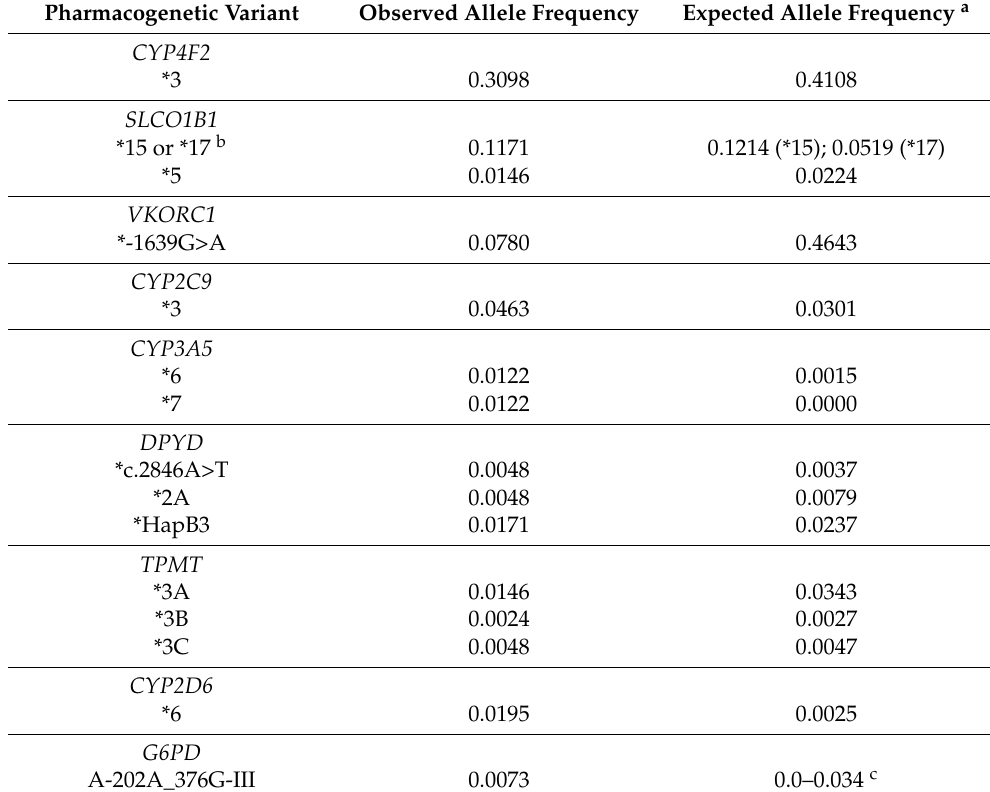
Table 3. Pharmacogenomic variants, observed allele frequencies in University of Kentucky family medicine patients, and expected population allele frequencies. There were no variant CACNA1S , CFTR , CYP2C19 , HLA-B , or RYR1 alleles in our